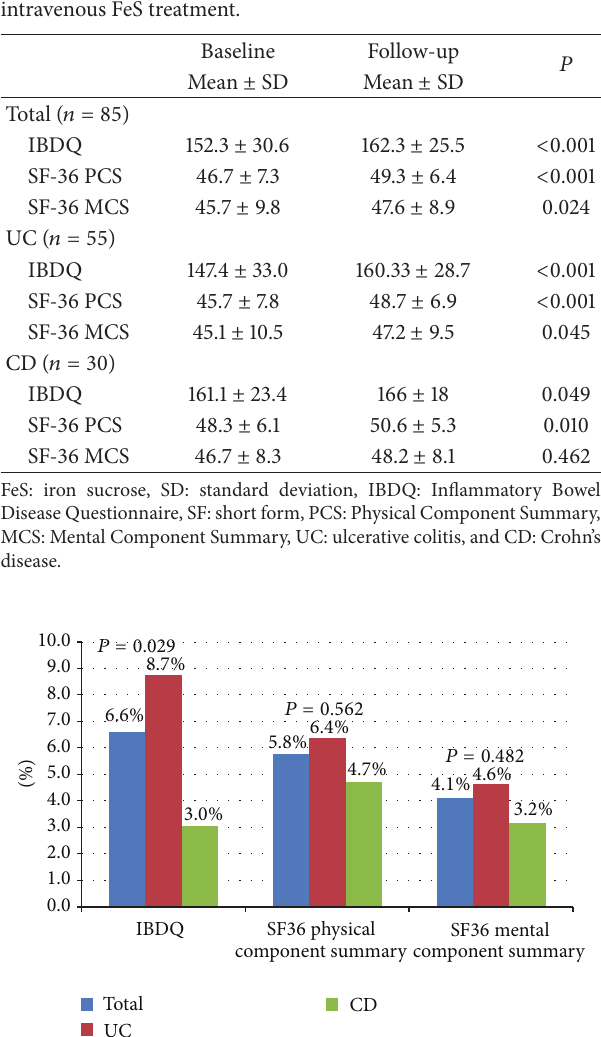
Table 1: Descriptive statistics of demographic variables ( 𝑛 = 85 ).